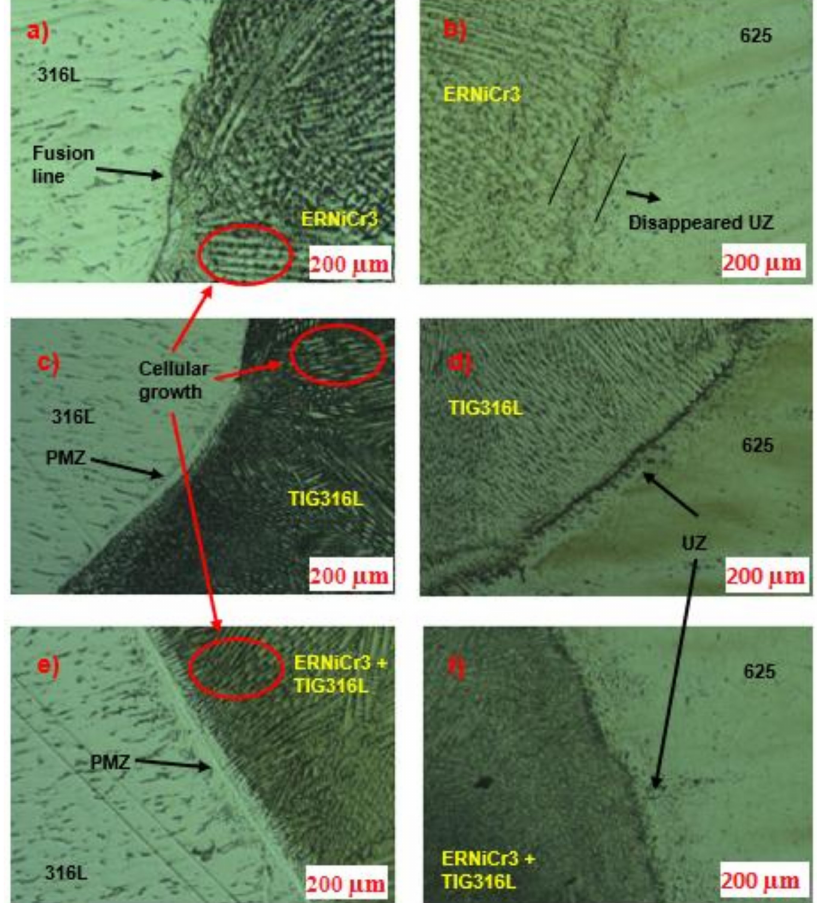
Figure 4. Microstructures of bimetallic joints of Inconel 625 and AISI 316L obtained by CCGTA welding, employing ERNiCr3 ( a , b ), TIG 316L ( c , d ), Twisted Fillers ( e , f